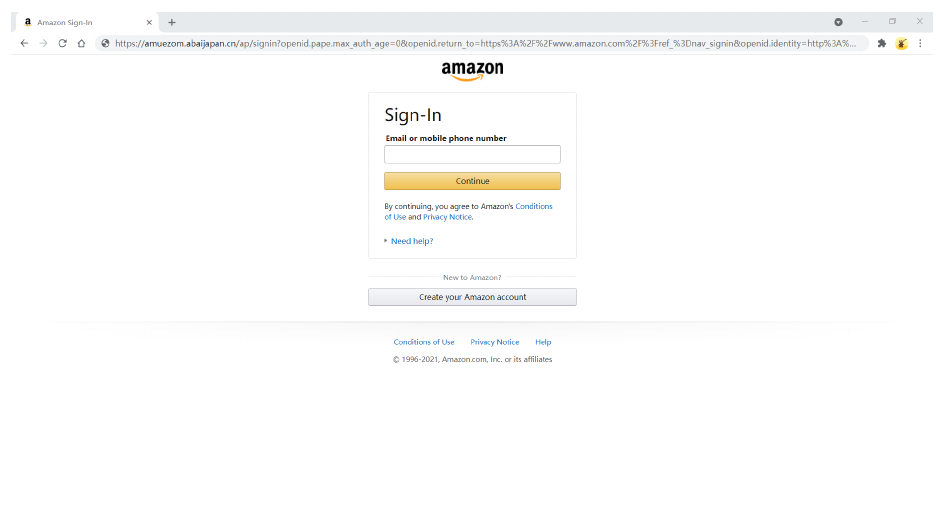
Figure 1. Example of phishing website.